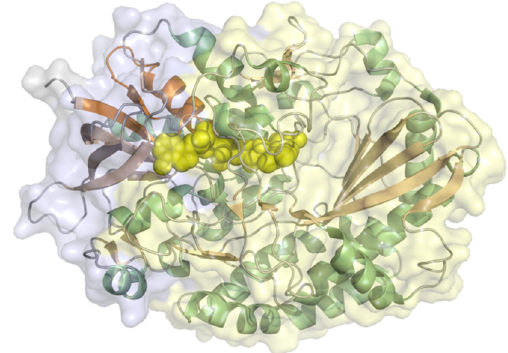
Figure 5. Crystal structure of Aspergillus flavus glucose dehydrogenase (PDB: 4YNT) with the FAD cofactor (yellow spheres) buried inside the protein shell. The FAD-binding and substrate-binding subunits are colored light blue and light yellow, respectively. The GMC-oxidoreductase family characteristic dinucleotide binding βαβ -motif (Rossmann-fold) is highlighted in orange.